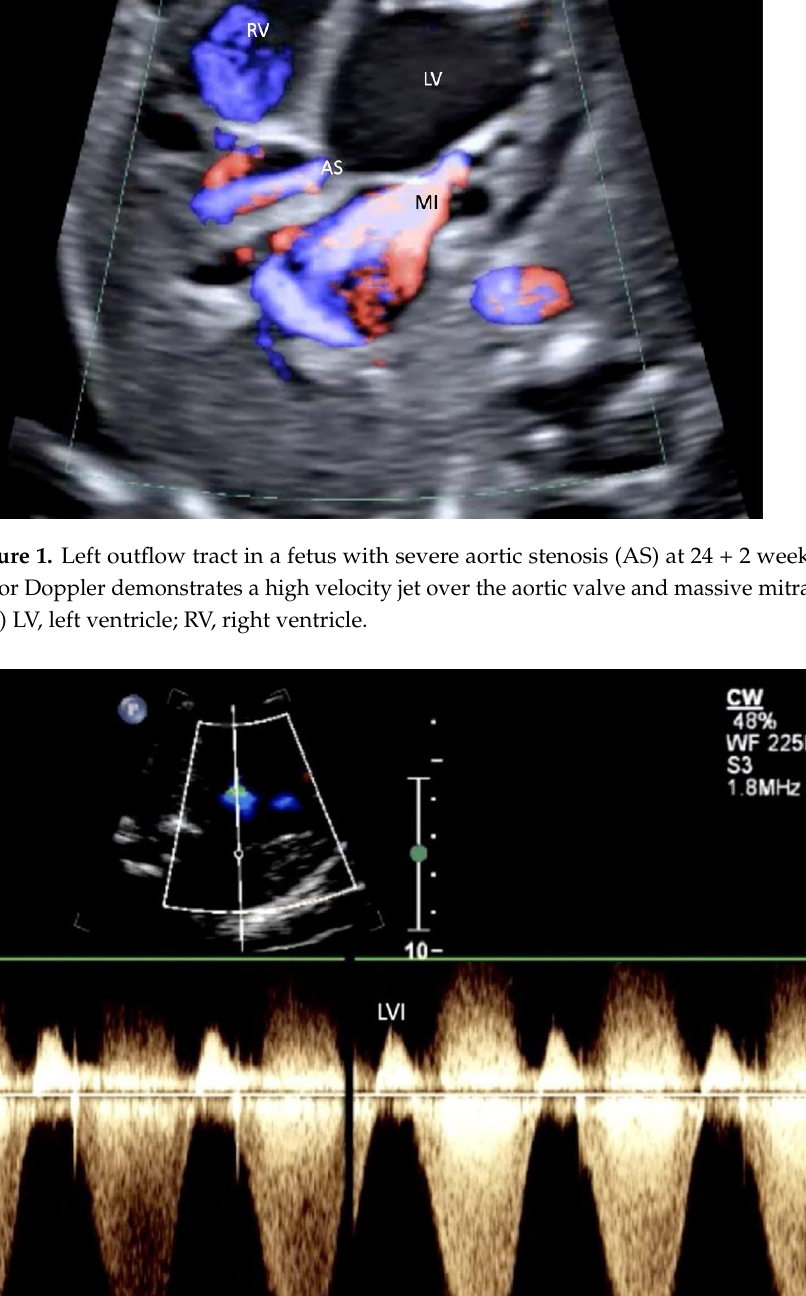
Figure 2. Continuous wave (CW) Doppler of the mitral wave in a fetus at 24 + 4 weeks of gestation with severe aortic stenosis demonstrating still holodiastolic inflow in the left ventricle (LVI) and holosystolic mitral insufficiency (MI) with a maximum velocity of 400 cm/s.